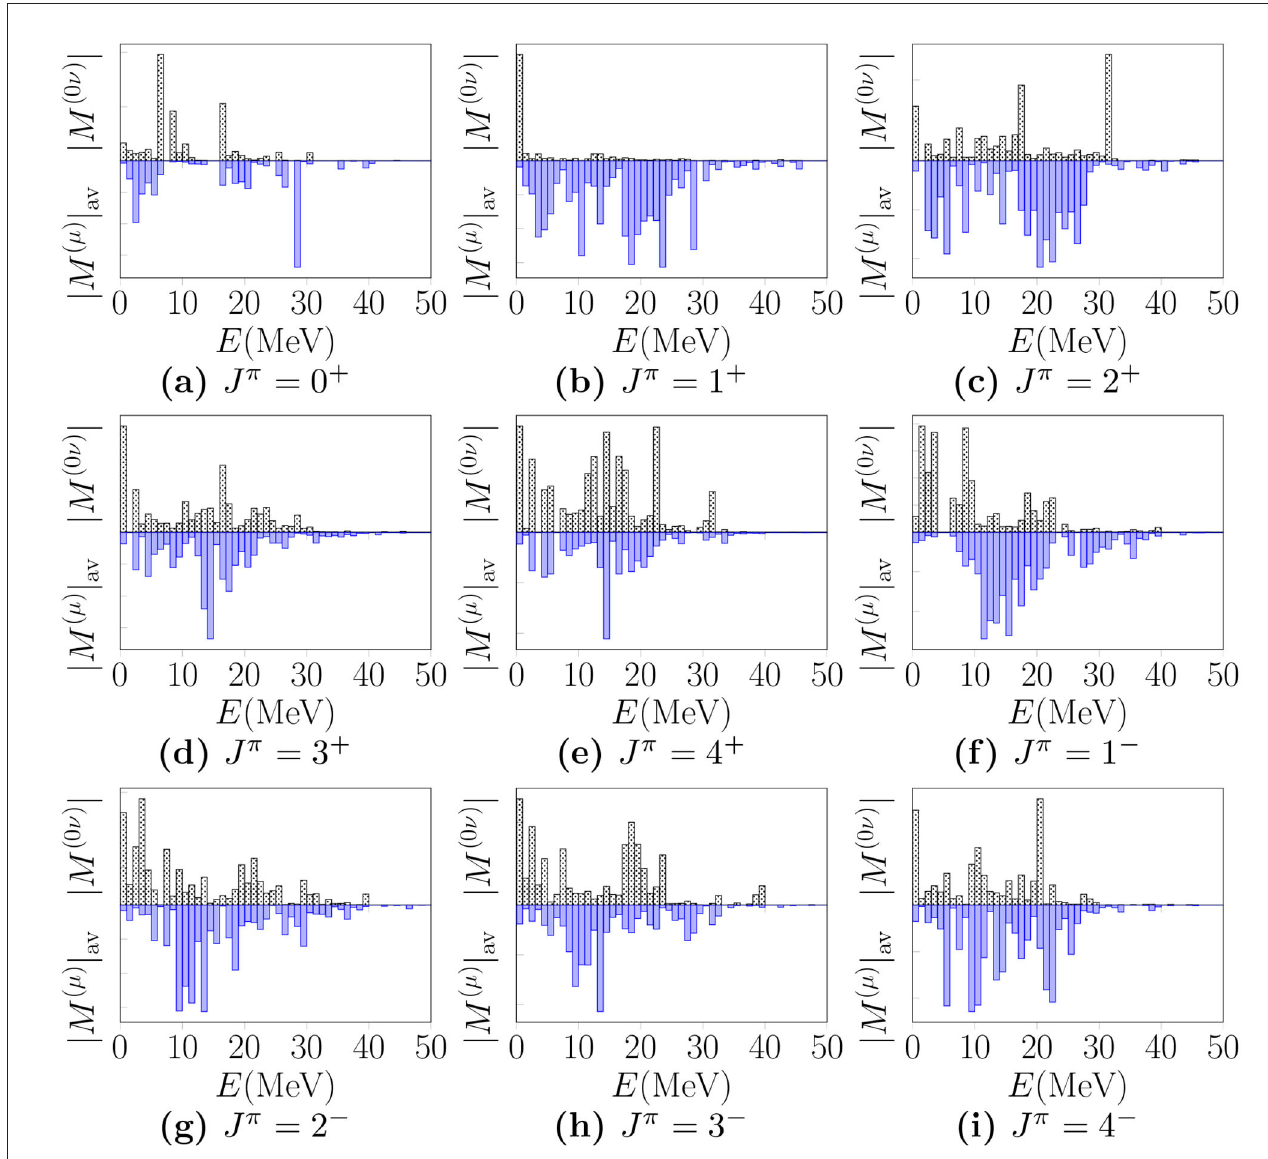
FIGURE 11 | Multipole decompositions in terms of relative 0 νβ + β + -decay matrix elements (positive y axes) and average matrix elements of the OMC (negative y axes) for 106 Cd as functions of the excitation energy E in the intermediate nucleus ( 106 Ag) of the 0 νβ + β + decay of 106 Cd. These matrix elements correspond the adjusted Woods-Saxon basis and g ( T = 0) pp = 0.7. For the bound-muon wave function we have used the realistic exact wave function solved from the Dirac equation. Here J π refer to the angular momenta and parities of the virtual states in 106 Ag and all quantities have been summed within 1 MeV energy bins. The subfigures represent different J π values. The scale values of the y axes have been omitted, since they are not relevant for the current analysis. For more information see the text.